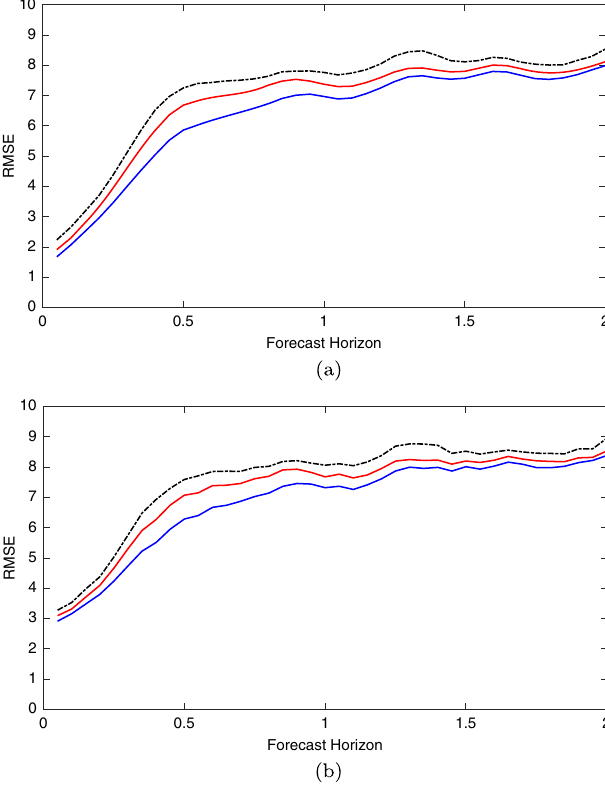
FIG. 4. Results of forecasting the Lorenz-63 x variable when the training data are perturbed by 30% noise. Results averaged over 3000 realizations. Forecast error calculated with respect to (a) the non-noisy truth and (b) the noisy truth. When the training data are filtered by the Kalman-Takens filter (solid red curve) we gain improved forecasting capability as compared to use of the unfiltered training data (dotted black curve). The forecasting results (using identical forecast algorithms) when the training data are filtered by the parametric filter (solid blue curve) are included for a point of